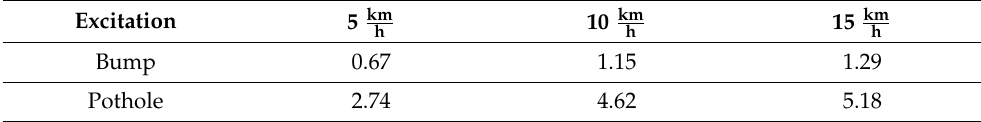
Table 9. The values of the RMS of acceleration for the sprung and the unsprung mass of the Quarter Car model for the periodic